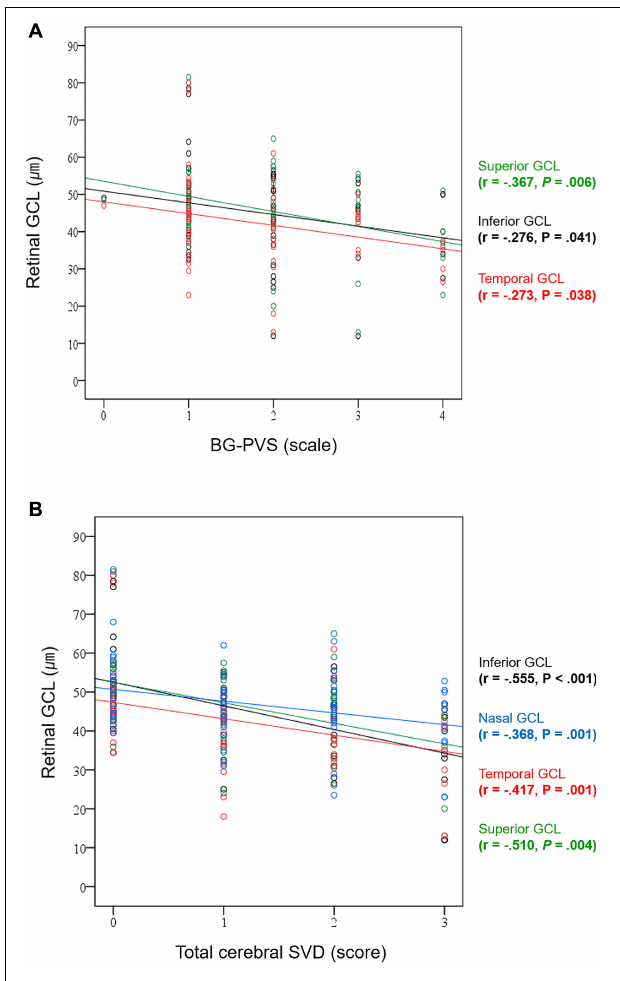
FIGURE 4 | Correlation plots between (A) BG-PVS severity and GCL thickness and (B) total cerebral SVD score and GCL thickness.